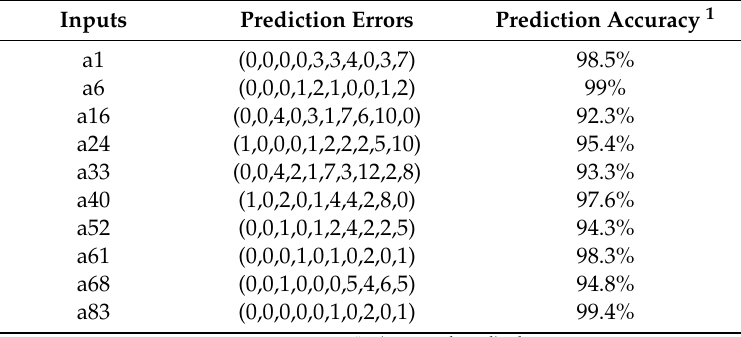
Table 4. Prediction results based on the noisy dataset.